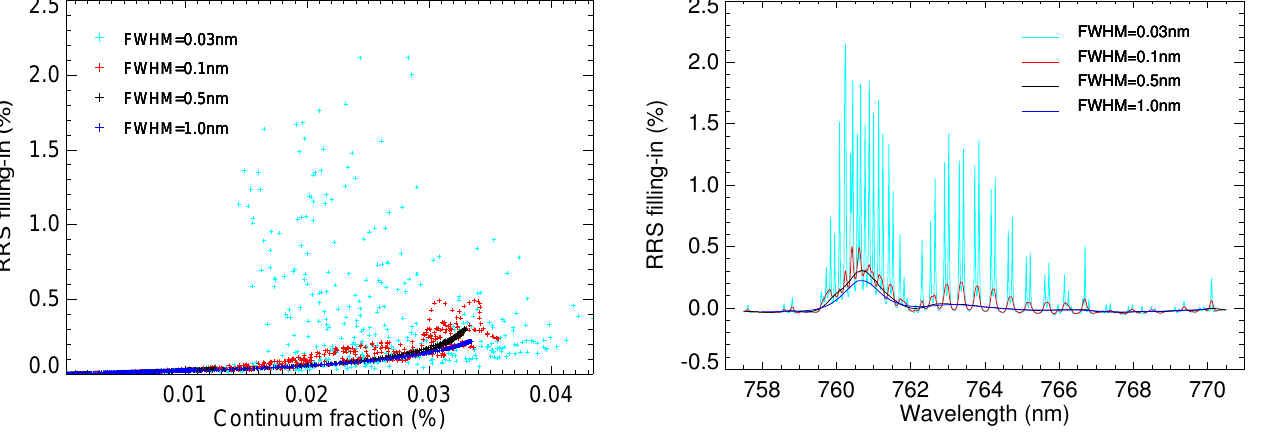
Fig. 12. Similar to Fig. 4 but computed with the higher spectral sampling solar irradiance (0.001 nm). Fig. 10. RRS signal defined as a percentage of the spectral elastic radiance versus the RRS signal defined as a percentage of the continuum level radiance at 758 nm. Every point represents a wavelength around the O 2 A-band. Only positive filling-in values are shown. Input parameters are similar to those used in Fig. 4.